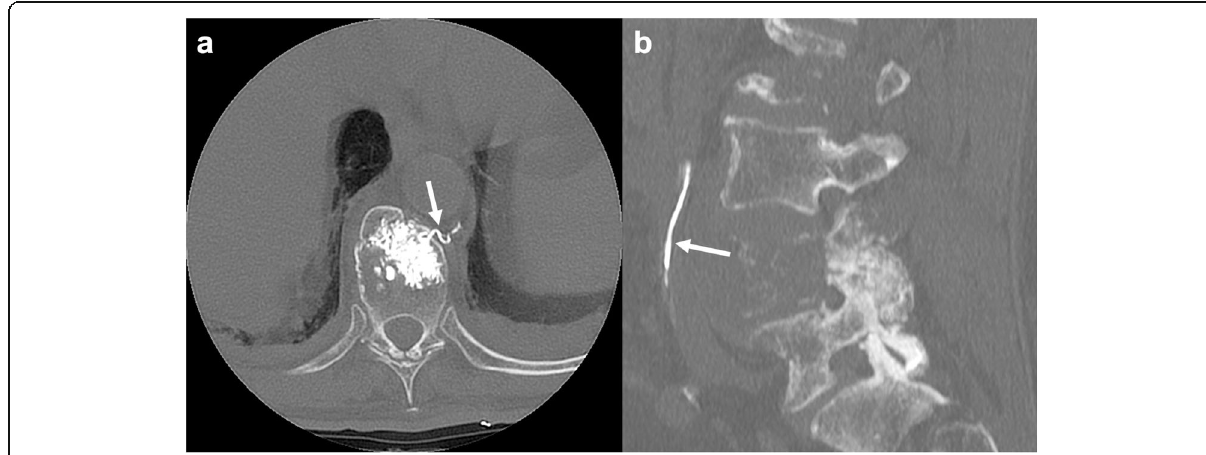
Fig. 11 Polymethylmethacrylate migration through veins. Axial ( a ) and sagittal ( b ) unenhanced CT presenting cement migration through an external anterior plexus vein (arrow in a ) to the inferior vena cava (arrow in b